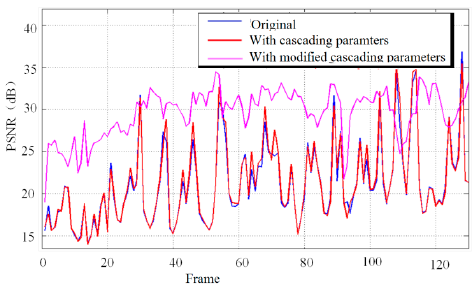
Figure 17. Comparison of PSNR values for the source video, the filtered video, and the filtered video with modified cascading.